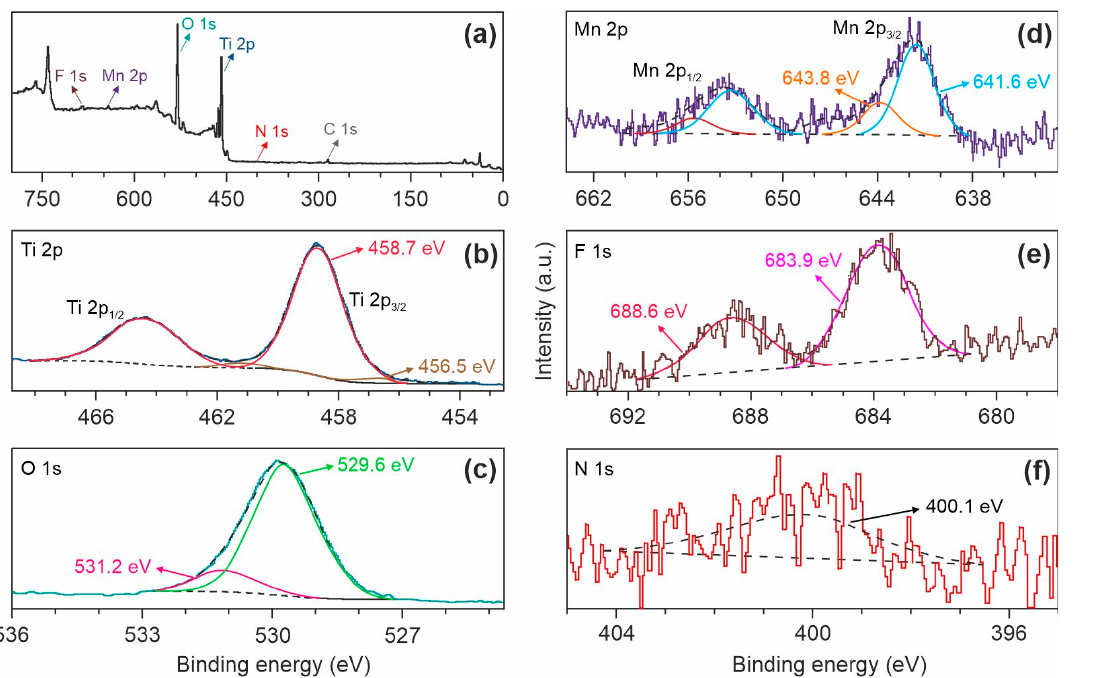
Figure 4. ( a ) XPS survey spectrum and corresponding high-resolution scans of the ( b ) Ti 2p, ( c ) O 1s, ( d ) Mn 2p, ( e ) F 1s, and ( f ) N 1s peaks for the TO-Mn/F/N-06 sample.